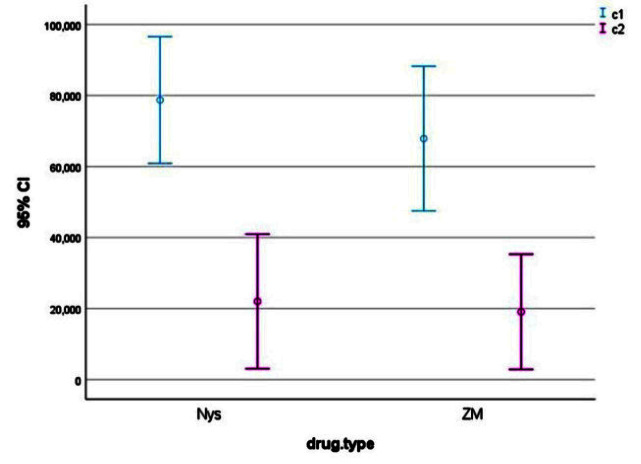
 Colony count (CFUs) before and after treatment in the two groups